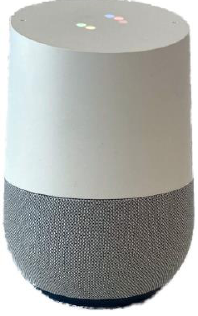
Figure 11. Google Home EU.